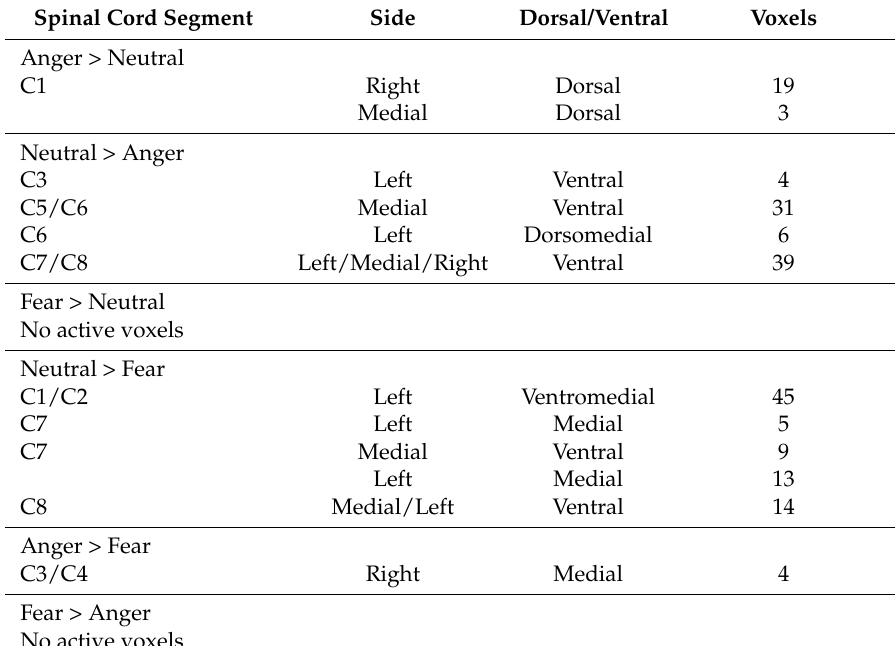
Table 3. Location of spinal cord activity in the contrasts for the unconscious perception of neutral, angry, and fearful faces. Results are presented at p < 0.0056; results containing 1 or 2 voxels have been excluded as they are likely false